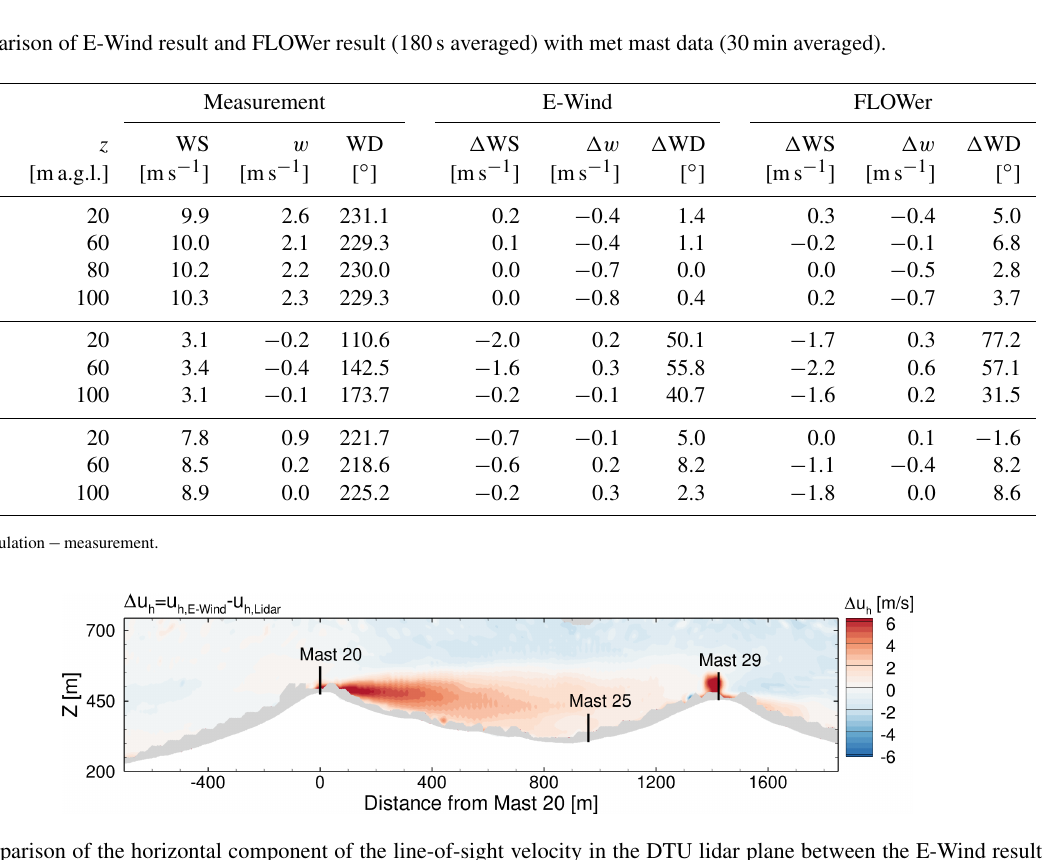
Figure 7. Comparison of the horizontal component of the line-of-sight velocity in the DTU lidar plane between the E-Wind result and the